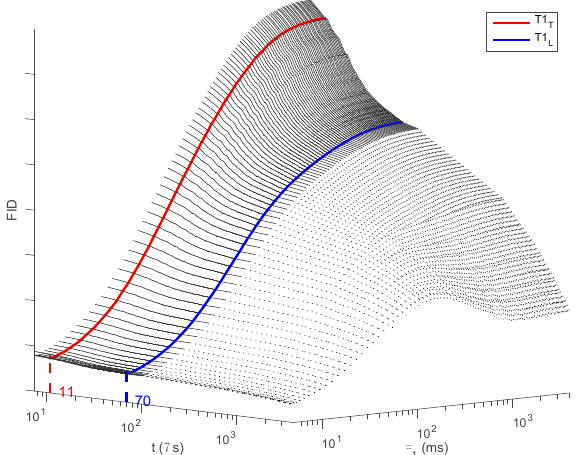
Figure 1. Scheme of both signal measurements: FID (in light gray) and the signal actually measured (in dark grey).